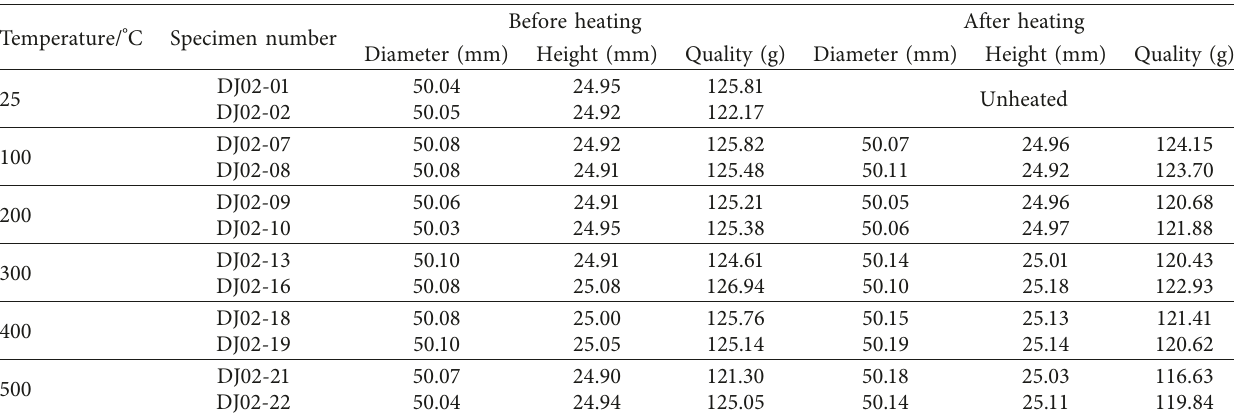
Table 2: Basic physical parameters of intact